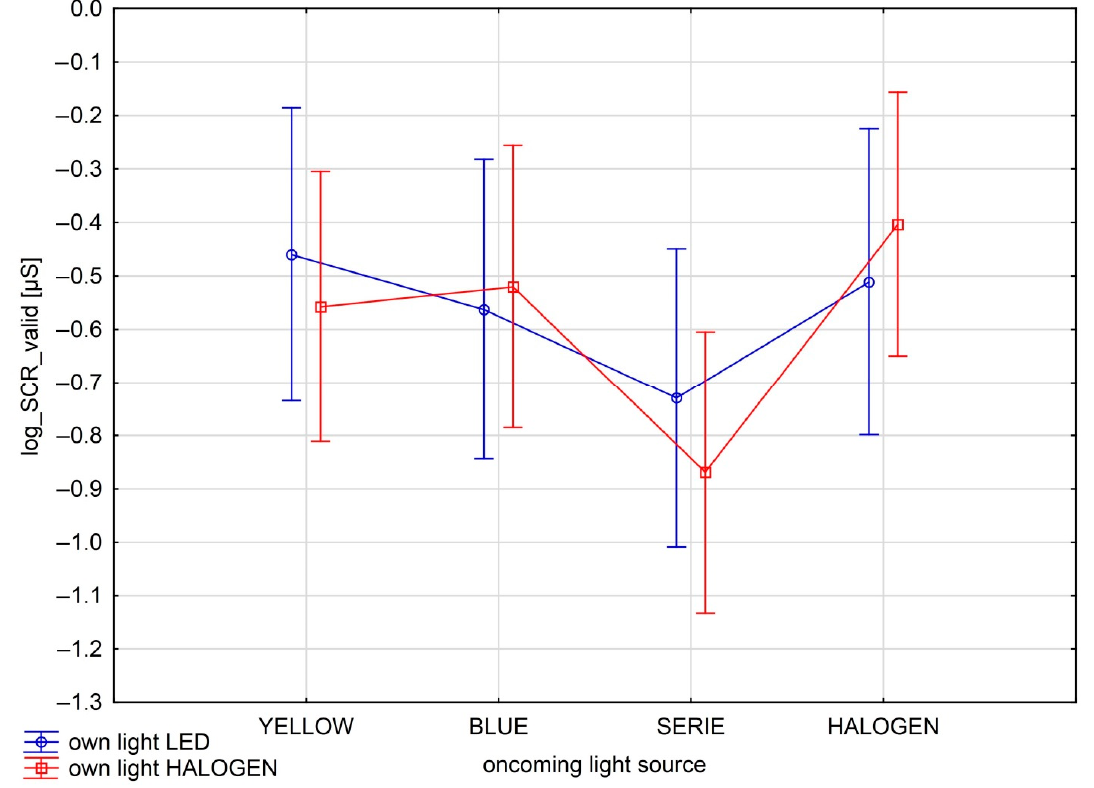
Figure 4. Relationship between SCR and the combination of the driver’s and the oncoming traffic’s headlights.